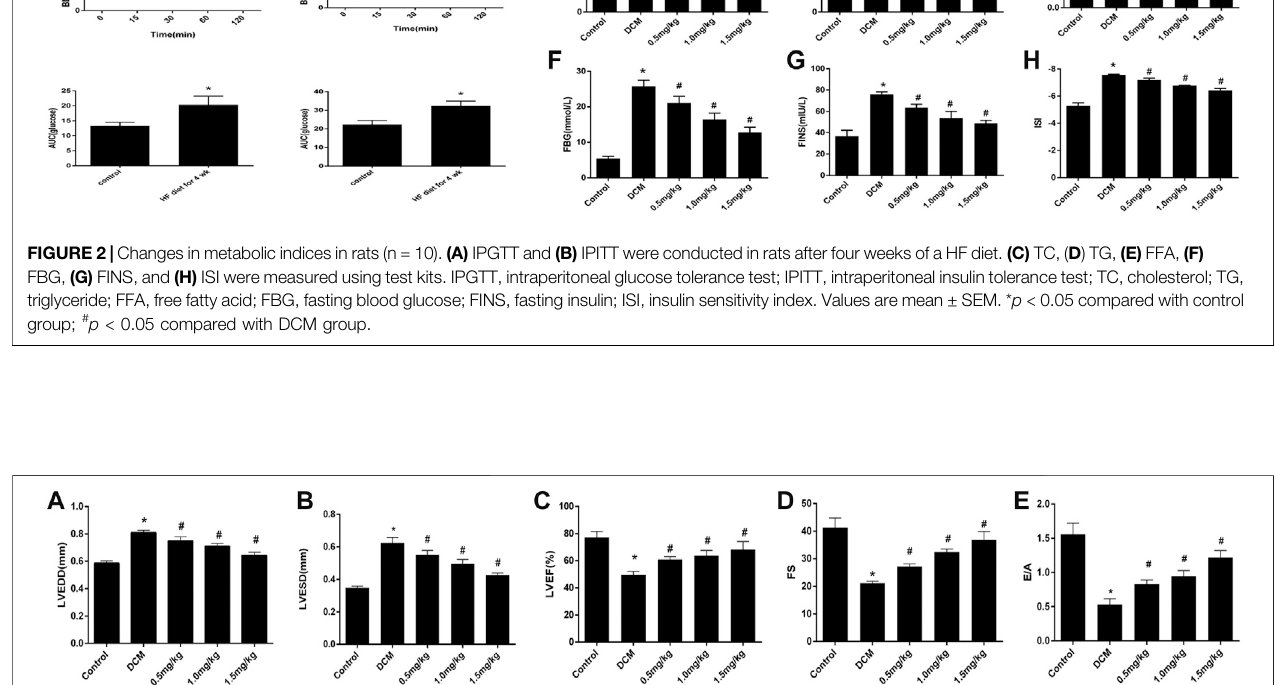
FIGURE3| Mizagli fl ozin improved cardiac functionin diabetic hearts (n (cid:1) 10). LVEF, leftventricularejectionfraction;LVFS, left ventricular systolicfunction; LVEDD, leftventricularend-diastolicdimension;LVESD,leftventricular end-systolicdimension.Valuesaremean ± SD, p < 0.05.* p < 0.05versuscontrol; # p < 0.05versusDCM.